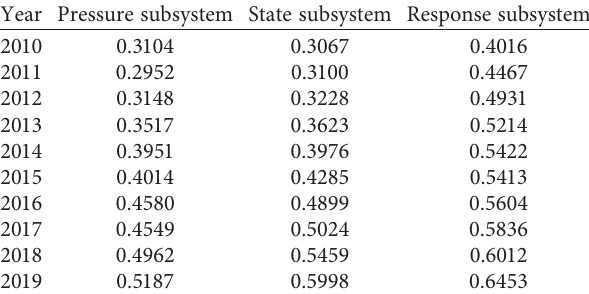
Table 2: Scores of the three subsystems,